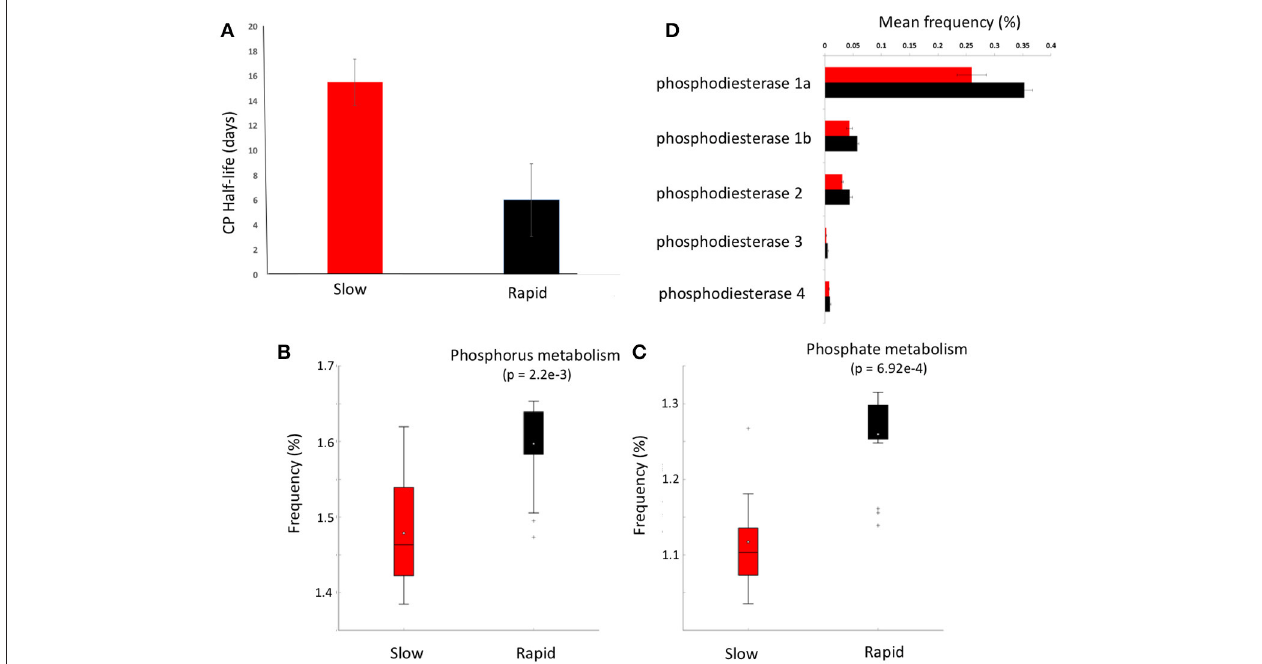
FIGURE 3 | Chlorpyrifos (CP) degradation potential. (A) Mean half-life of CP after the third application of pesticide to each soil in samples forming clusters in metagenomic ordinations, boxplots of metabolic function abundance for (B) phosphorus metabolism, (C) phosphate metabolism ( p < 0.05), and (D) relative abundance of phosphodiesterase enzymes in clusters ( t -test of differences in abundance p < 0.05). Error bars = SD and red represents slow degrading cluster, black represents rapid degrading cluster. Phosphodiesterase 1a and 1b, diguanylate_cyclase/phosphodiesterase_(GGDEF_&_EAL_domains_with_PAS/PAC_sensor(s); 2, Glycerophosphotyl_diester_phosphodiesterase_[EC_3.1.4.46); 3, 2’,3’-cyclic-nucleotide_2’_phosphodiesterase_[ec_3.14.16]; 4, Alkaline_phosphodiesterase_1_[EC_3.1.4.1__Nucleotide_pyrophosphatase_(ec_3.6.1.9).